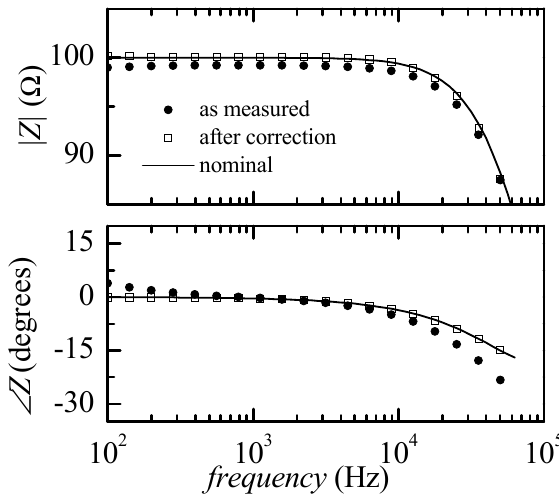
Figure 6. Measurements on a test impedance as in in Figure 3 with R ext = 100, C = 10 nF and R in = 100. The black dots are the measurement results when no correction is applied. The empty squares are the measurement results corrected with the calibration function H C obtained from a previous measurement on a single 100 Ω resistor. As it can be noticed, after correction, the measurement essentially coincides with the nominal value of the tested impedance at each frequency (black line).